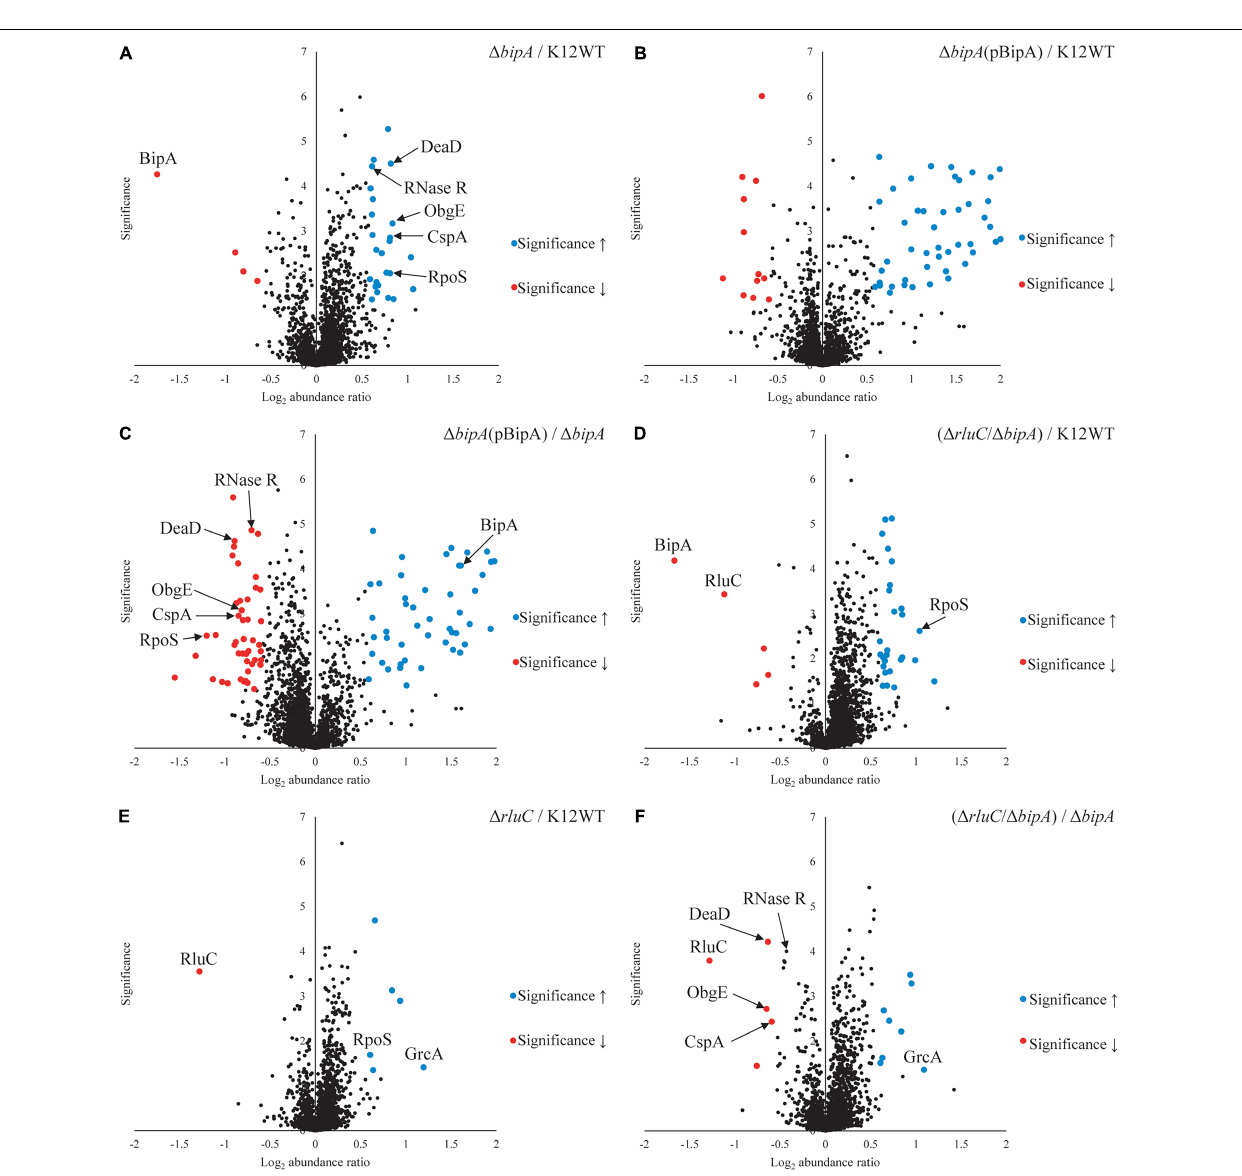
FIGURE 4 | Tandem mass tag-mass spectrometry (TMT-MS) analysis of various strains of E. coli K12 BW25113. A TMT-based quantitative proteomic method was used to determine differential protein expression under suboptimal cell culture condition between wild-type, (cid:49) bipA (pCA24N-BipA), and (cid:49) rluC/ (cid:49) bipA strains. (A) A volcano plot showing protein expression level of the strain (cid:49) bipA against the strain K12WT. The bipA was indeed deleted based on significantly low log 2 FC. The five proteins DeaD, ObgE, RpoS, CspA, and RNase R yielded significantly higher reads in the strain (cid:49) bipA than the strain K12WT. (B) The expression levels of DeaD, ObgE, RpoS, CspA, and RNase R proteins were not changed between K12WT and (cid:49) bipA (pCA24N-BipA) strain. (C) Comparison of (cid:49) bipA (pCA24N-BipA) against (cid:49) bipA . We put DeaD, ObgE, RpoS, CspA, and RNase R in the negative log 2 abundance ratio side of the plot, meaning peptide reads of the proteins were lesser in the presence of pCA24N-BipA. The blue dot labeled as BipA was an indication that BipA was indeed expressed. (D) The rluC deletion in (cid:49) bipA background produced a volcano plot similar to (A) , but the DeaD, ObgE, CspA, and RNase R were close to K12WT as differential expressions against K12WT were not detected. As in (A,D) , higher readout of RpoS was detected in (cid:49) rluC / (cid:49) bipA . Red dots labeled with BipA and RluC showed that these bipA and rluC were indeed deleted. (E) Genomic deletion of rluC only yielded six differentially expressed proteins relative to K12WT, and out of which, two interesting changes were RpoS and GrcA upregulations. The significant negative log 2 abundance ratio of RluC indicates that the gene was indeed removed. (F) Comparisons between (cid:49) rluC / (cid:49) bipA and (cid:49) bipA showed a reduced expression level of the DeaD, ObgE, and CspA to wild-type level. The RNase R readout was found to be reduced by the loss of rluC , close to the cut-off for FC. The pBipA refers to